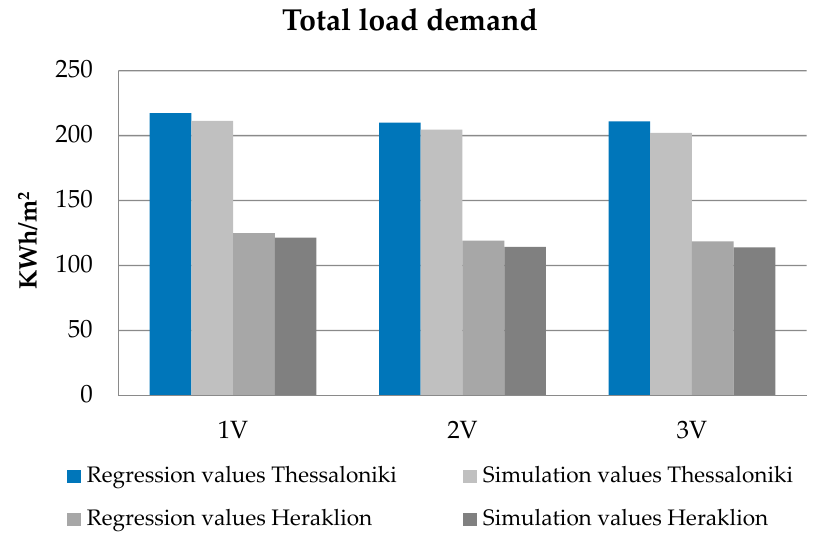
Figure 14. Regression model’s validation results for both climates.